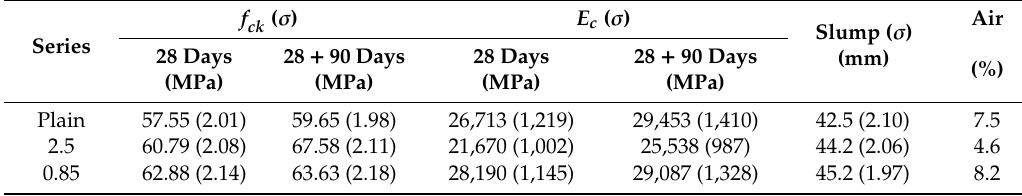
Table 6. Physical properties of concrete mixes.